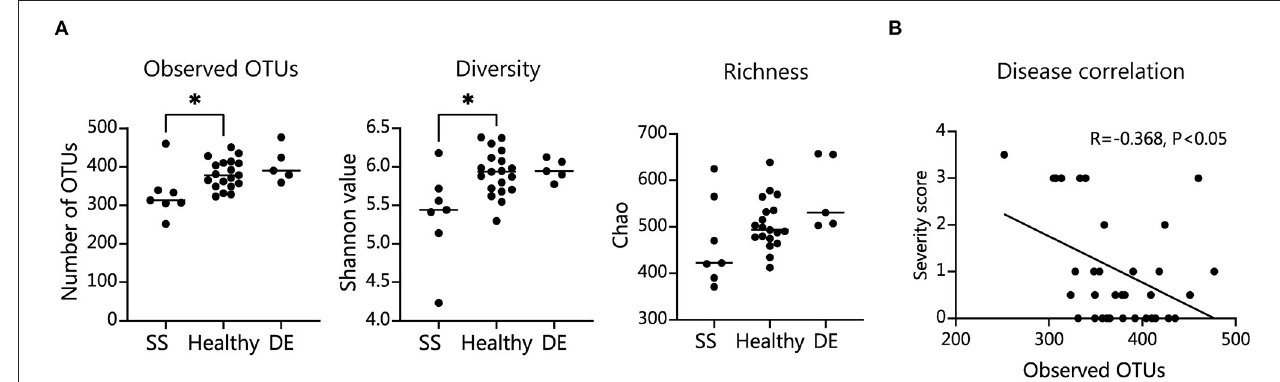
FIGURE 1 | SS patient microbiome alpha diversity is significantly decreased and correlates with disease severity. (A) Number of observed operational taxonomic units (OTUs), Shannon diversity measure, and Chao richness in patient fecal samples. Statistical significance was assessed using non-parametric Mann-Whitney U tests. * P ≤ 0.05. (B) Spearman’s correlation of combined severity index and number of intestinal OTUs; R, coefficient of